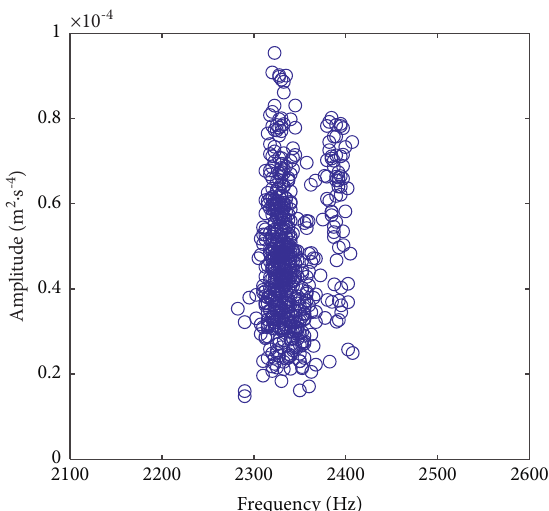
Figure 7: The distribution of high-frequency periodic component.